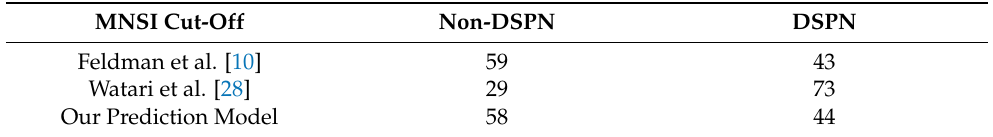
Table 11. Performance comparison of our proposed MNSI cut-offs for binary classification on an independent test cohort (Watari et al., 2014